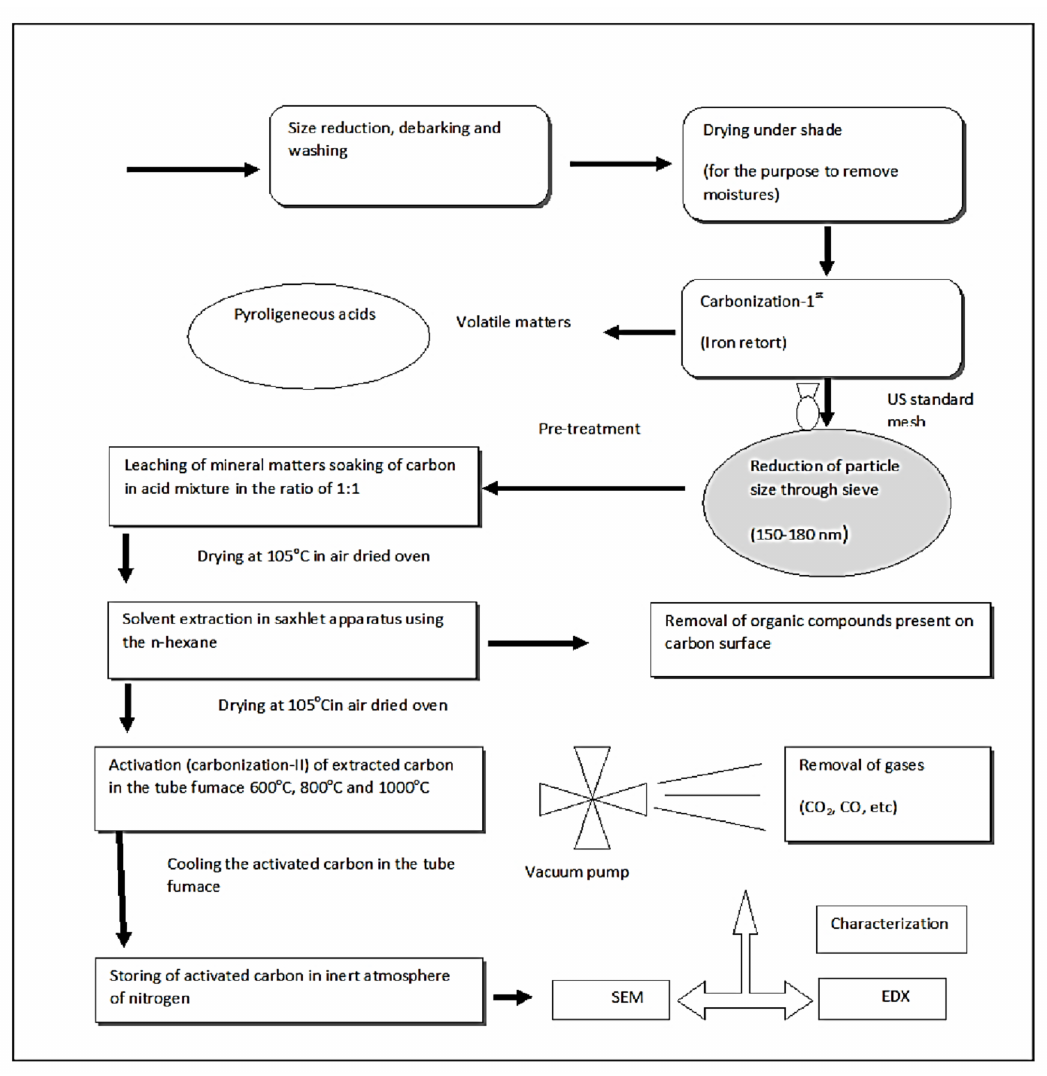
Figure 2. Preparation of activated carbon.